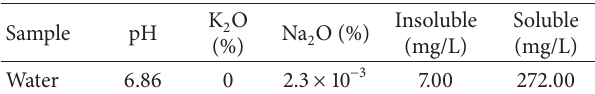
Table 3: Chemical analysis of water.